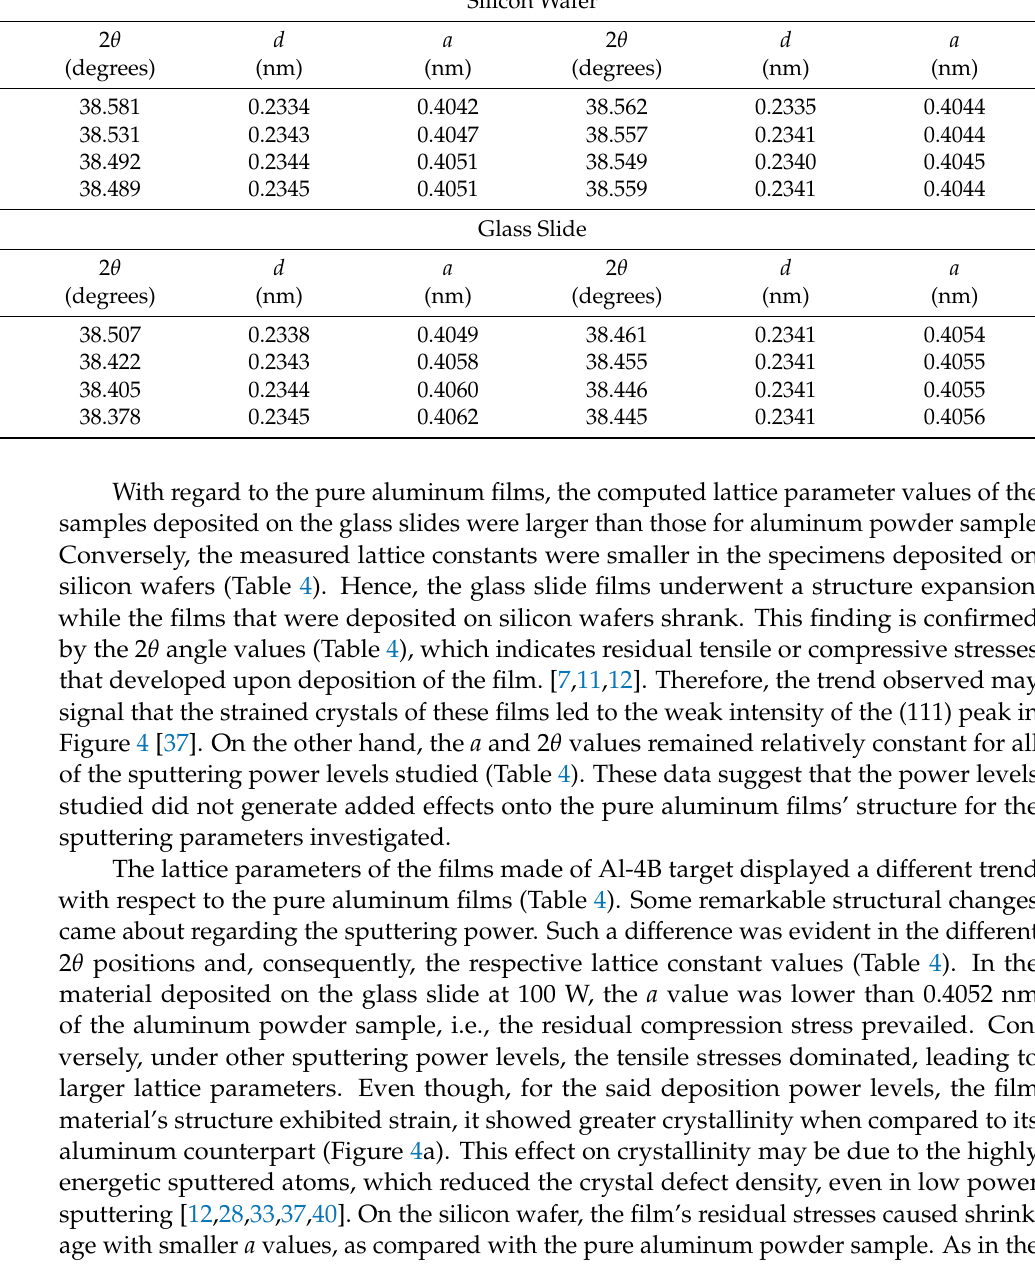
Table 4. Lattice parameters computed for the films that were deposited on the silicon wafer and glass slide substrates. Target Material Al-4B Al Substrate Silicon